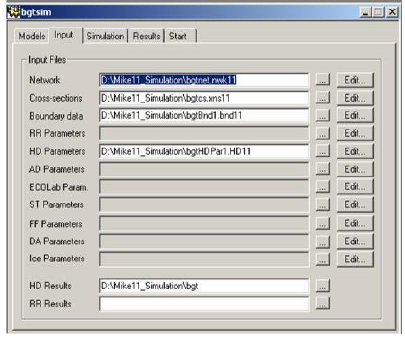
Fig. 3.6: Final simulation editor of mike-11